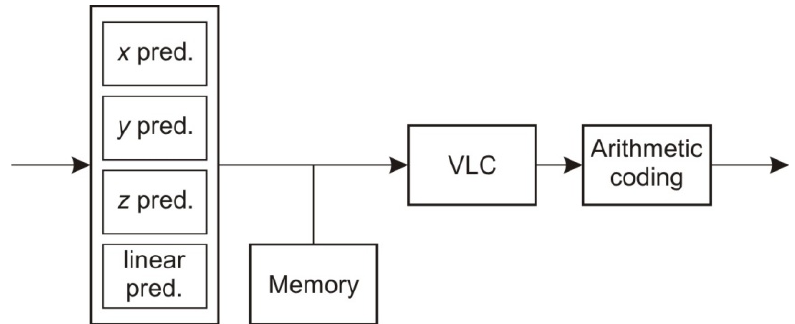
Figure 3. The structure of the hardware LIDAR data